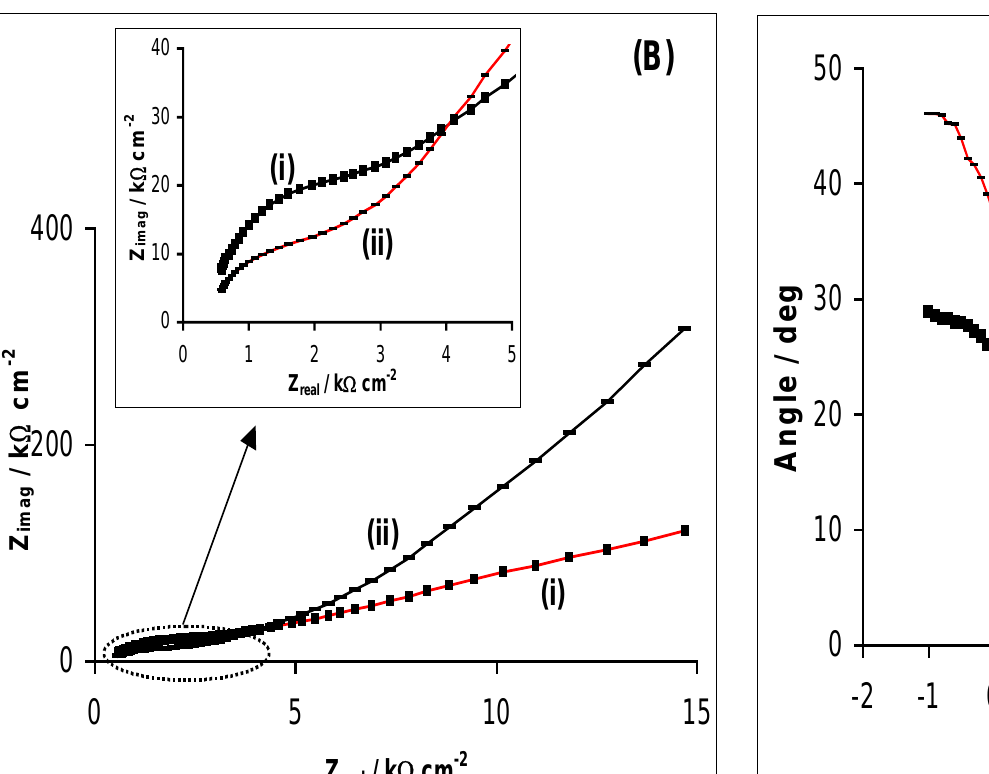
, R , CPE and Z values were estimated as 6.4 k Ω cm -2 , 56.9 k Ω cm -2 , 4.0 nFcm -2 For the bare, the R s ct w and 12x10 -4 Ω cm -2 s 1/2 , respectively. For the GCE-CoPc-(CoTPP) , values of 13.1 k Ω cm -2 , 14.6 k Ω cm - 4 2 , 86 nFcm -2 and 6.4x10 -4 Ω cm -2 s 1/2 were obtained for the R , R , CPE and Z , respectively. The R s ct w ct value for the modified electrodes is approximately a quarter compared to that of the bare GCE, which indicates that the pentamer facilitates the electron transfer process, thus corroborating the CVs of Fig. 3. The slightly higher CPE value for the GCE-CoPc-(CoTPP) reflects the uniformity of 4